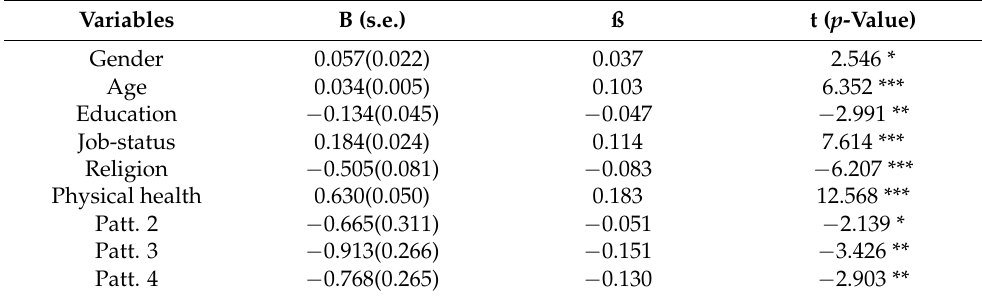
Table 6. Multiple Regression Analysis on Depression by Patterns 1